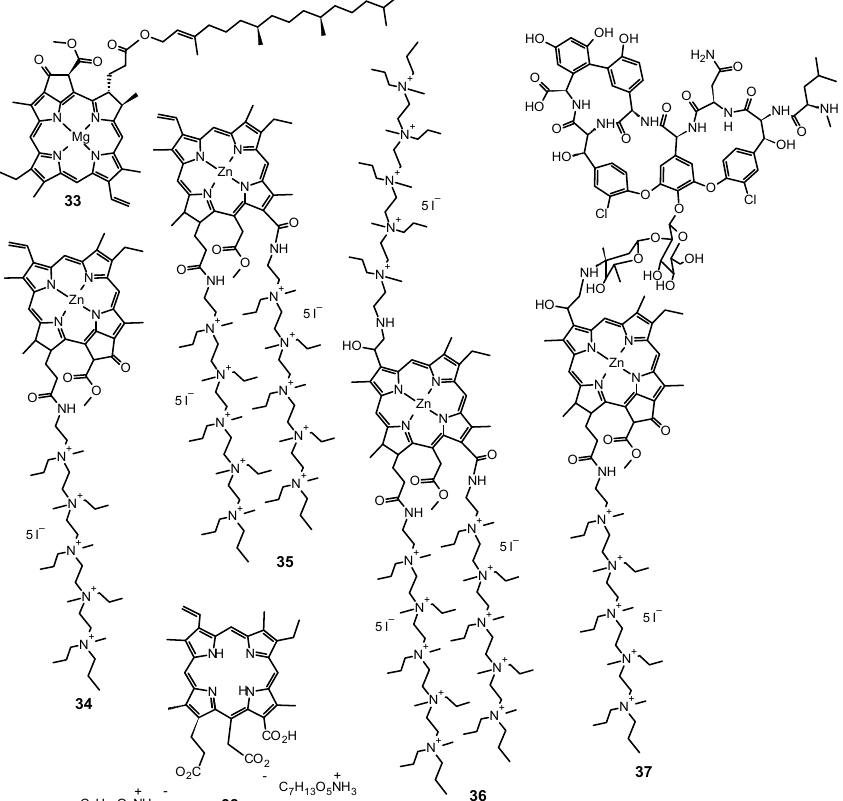
Figure 9. Chemical structures of chlorins ( 33–38 ) .